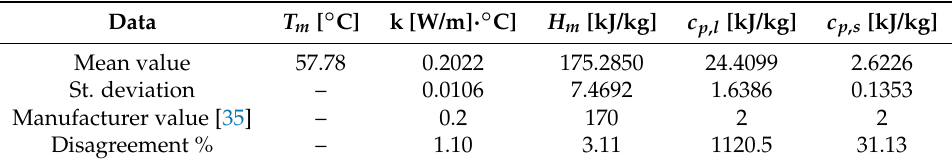
Table 5. Determination of thermal properties of RT55 with T-melting